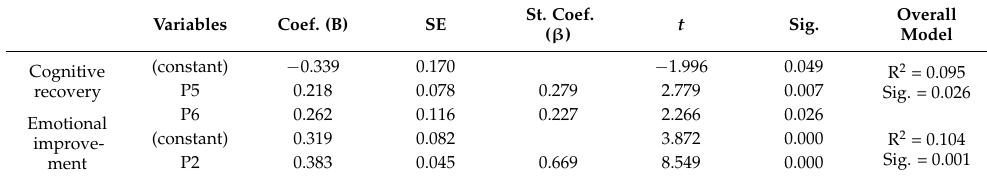
Table 6. Cognitive recovery, emotional improvement and park characteristics (stepwise model).